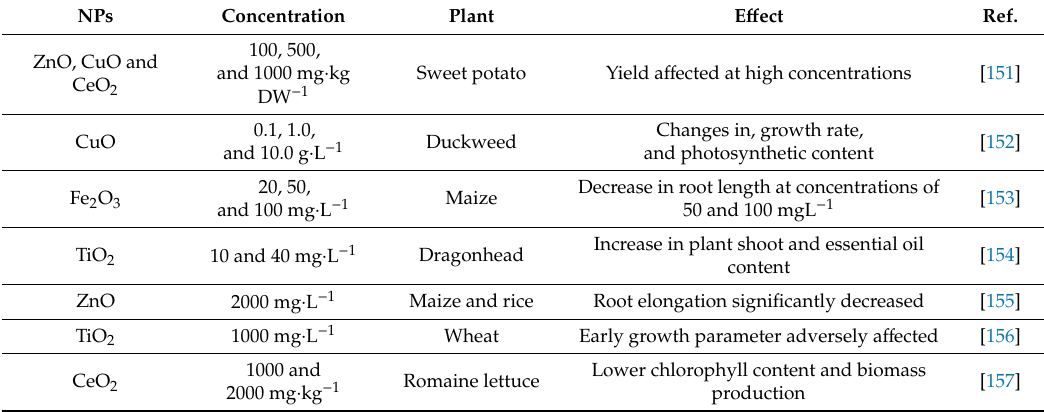
Table 3. E ff ects detected by the interaction of metal oxide NPs over di ff erent